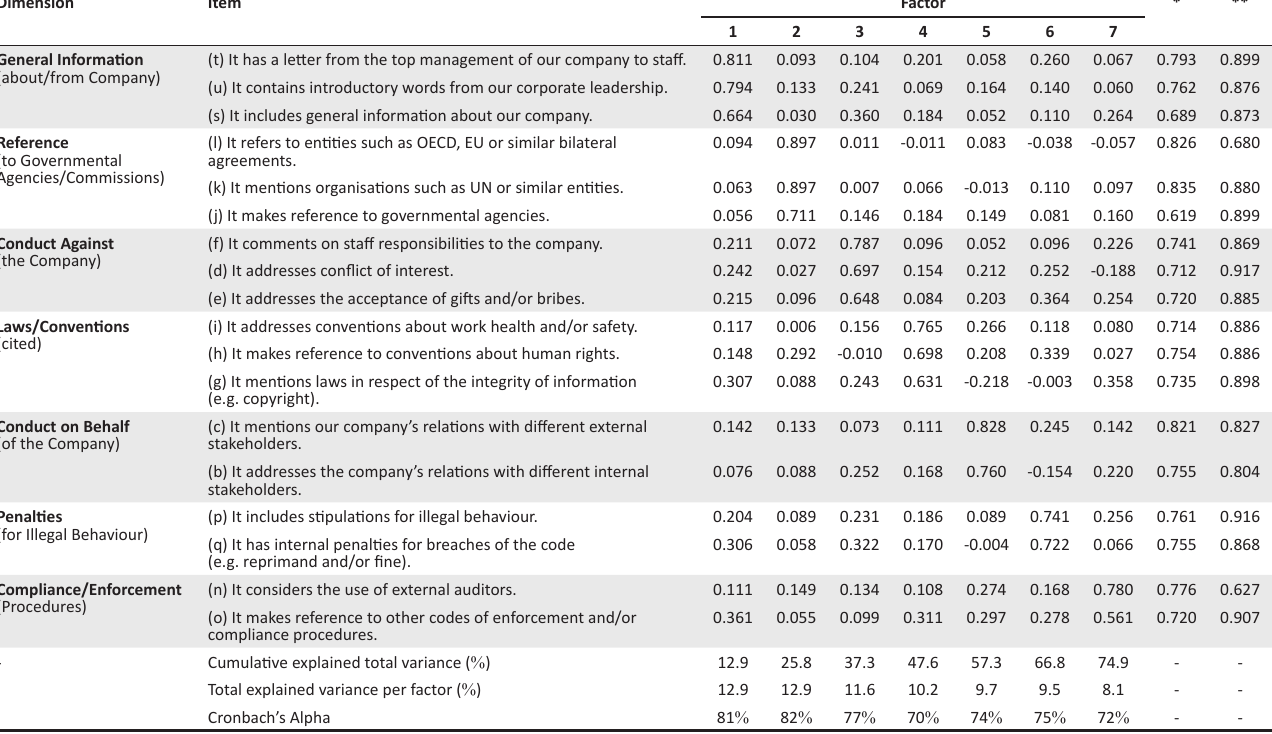
TABLE 2: Exploratory factor analysis – Code of ethics content. Dimension Item